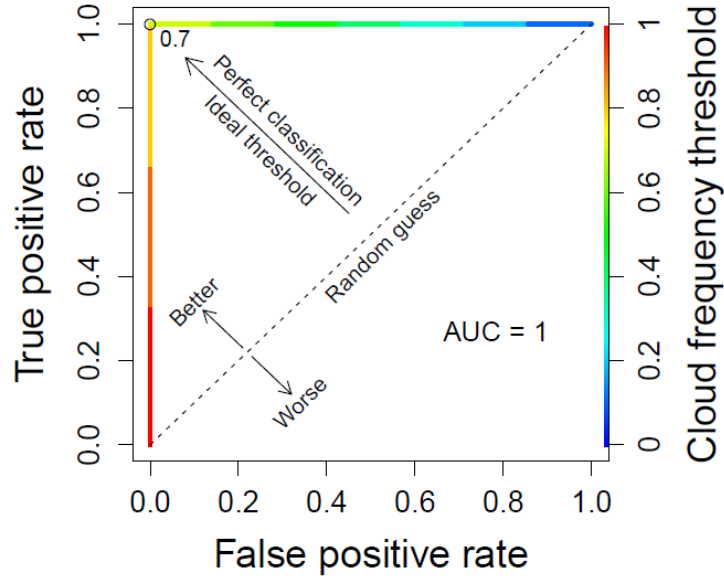
Figure 3. Idealized ROC curve which theoretically reveals a strong relationship between the frequency of low